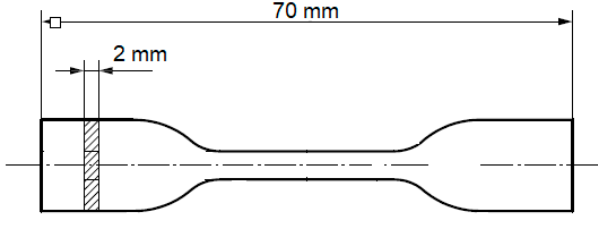
Figure 2. Injected dog bone sample.